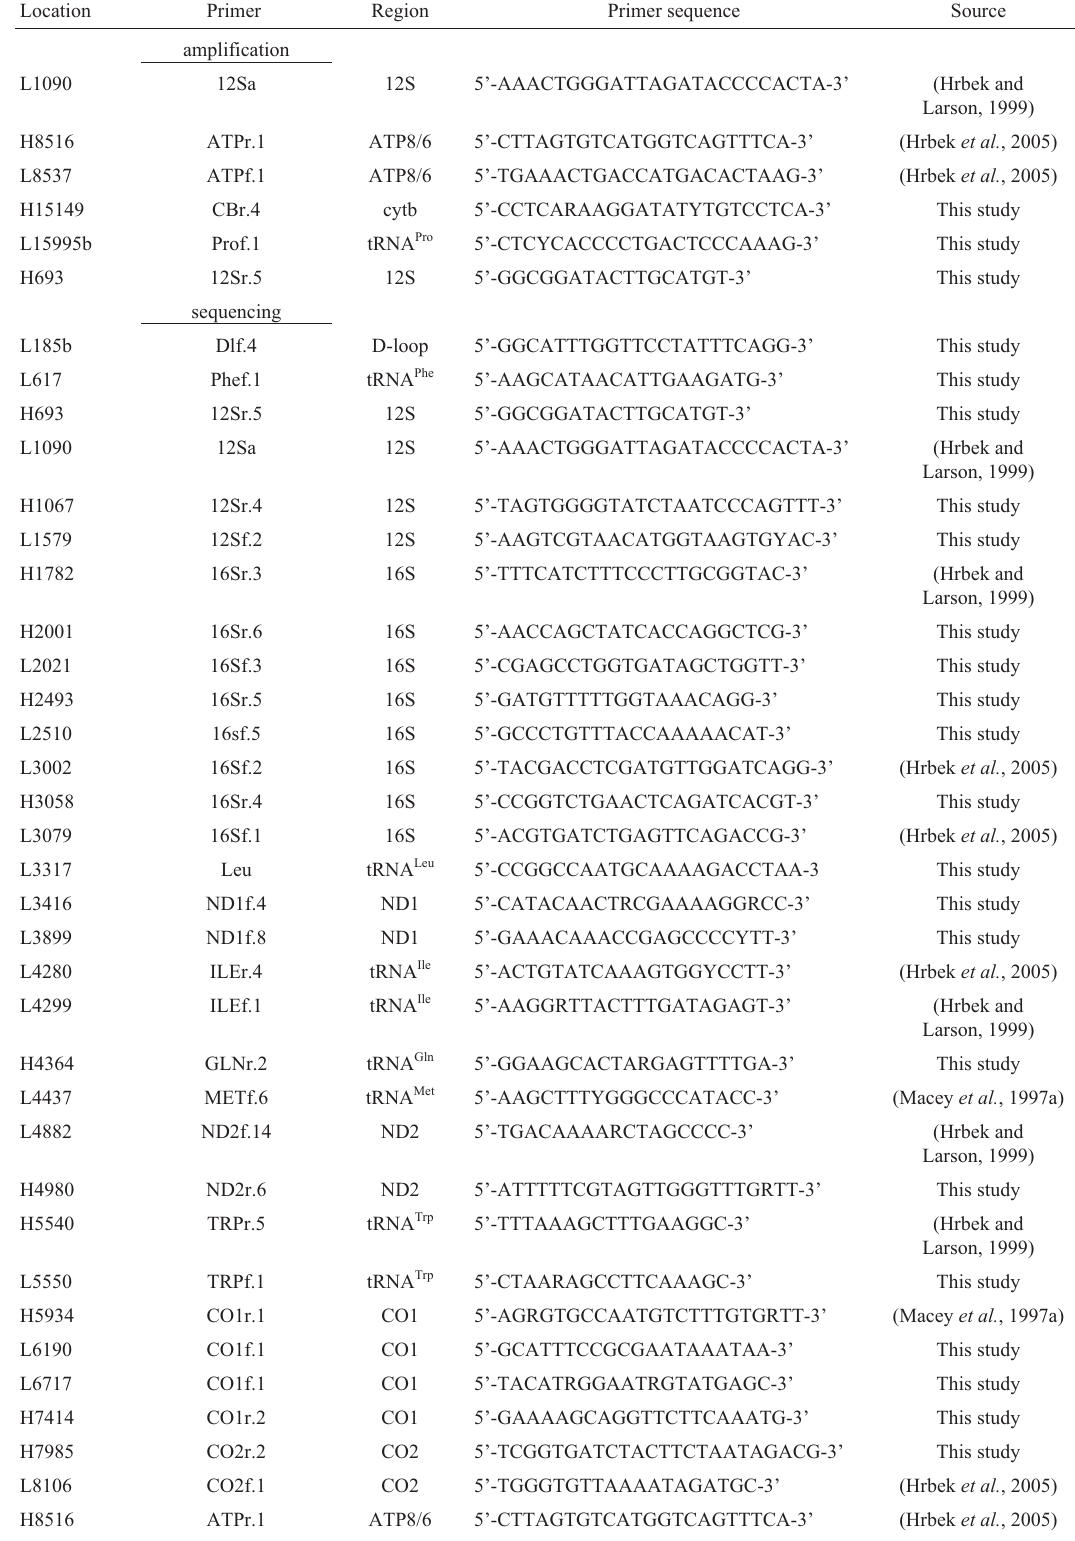
Table 1 - Primers used in the amplification and sequencing of the complete mitochondrial genome of Arapaima gigas . The primer designations corre- spondtotheir3’positioninthehumanmitochondrialgenome(Anderson etal. ,1981)byconvention.HandLdesignatetheheavyandthelightstrand,re- spectively. Many of the primers reported for the first time in this study are used in ongoing studies in our laboratory, or were derived from primers pub- lished in Miya and Nishida